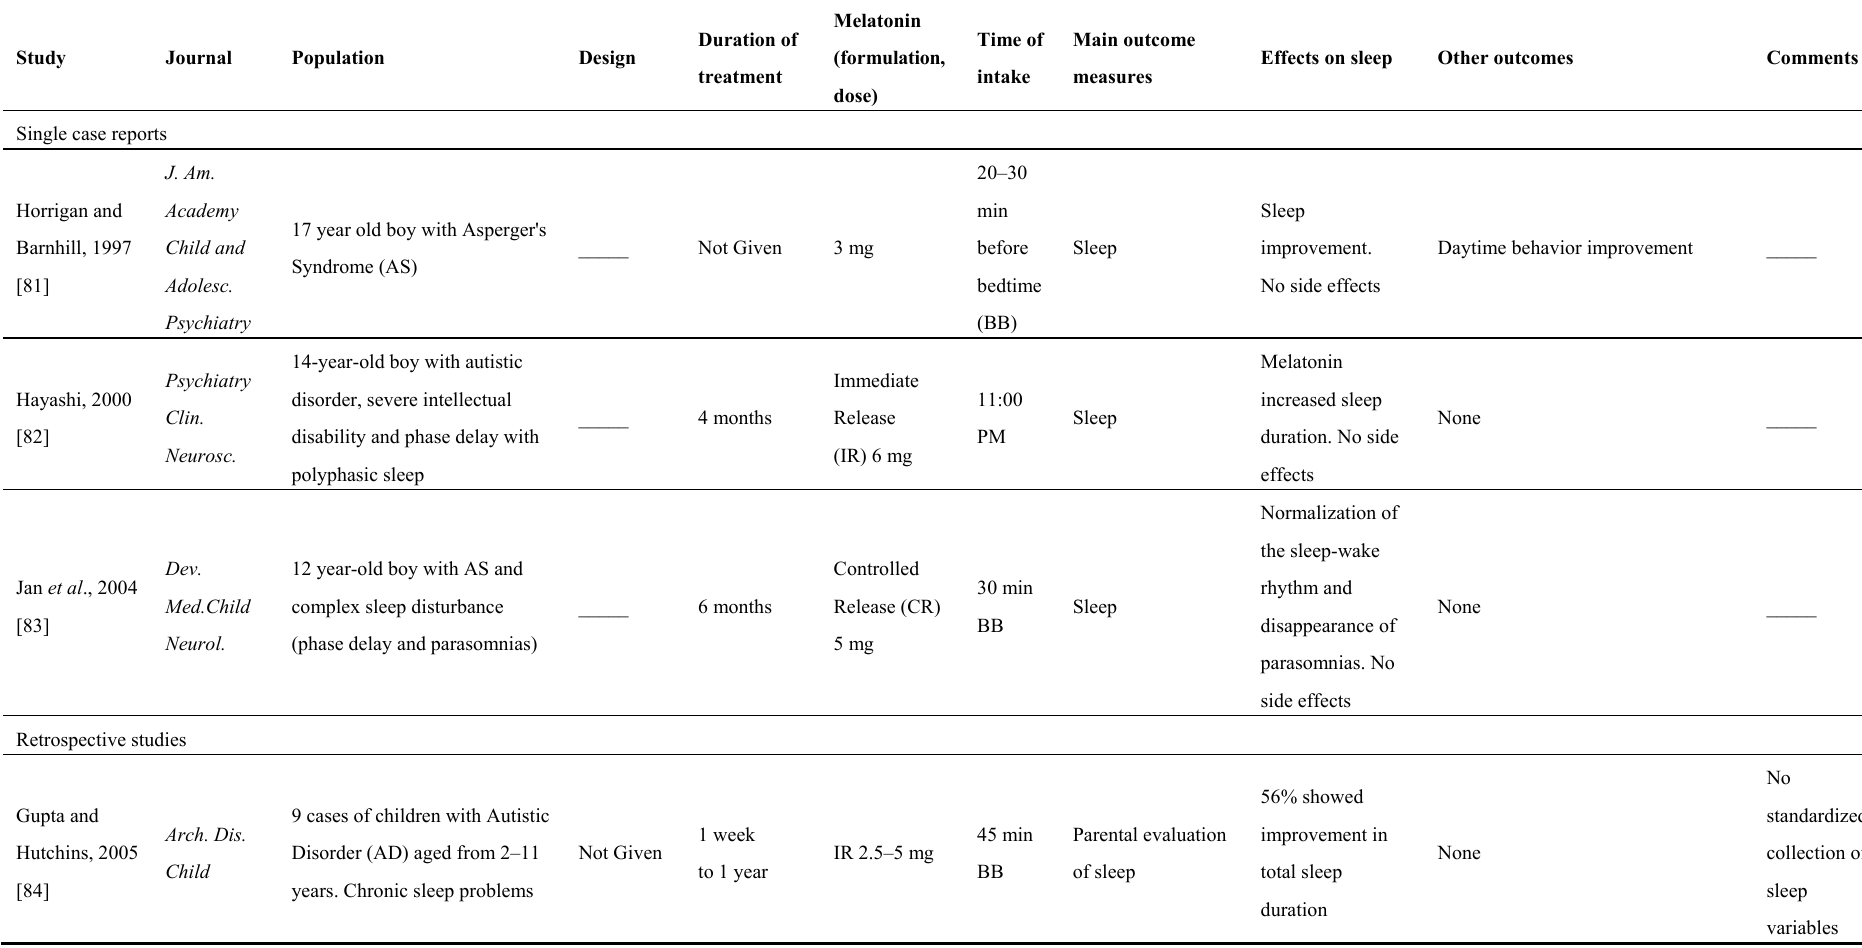
Table 2. Studies on potential therapeutic benefits of melatonin in autistic